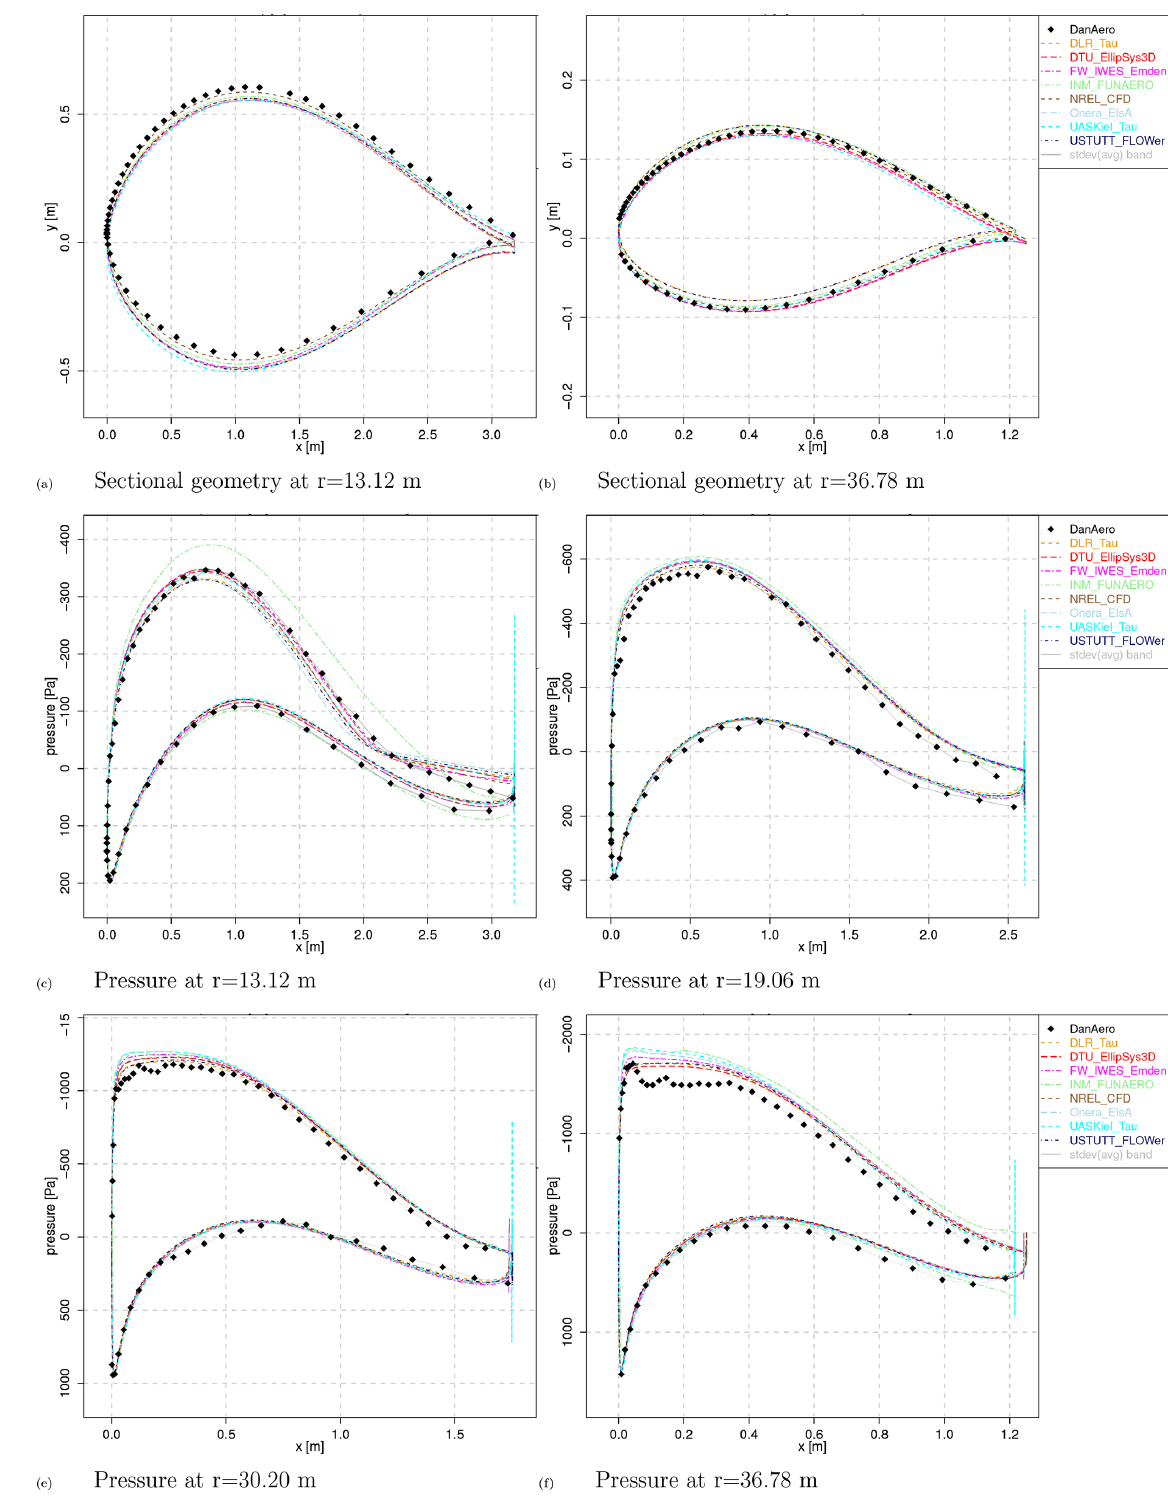
Figure 4. Sectional geometry and pressure distributions (Case